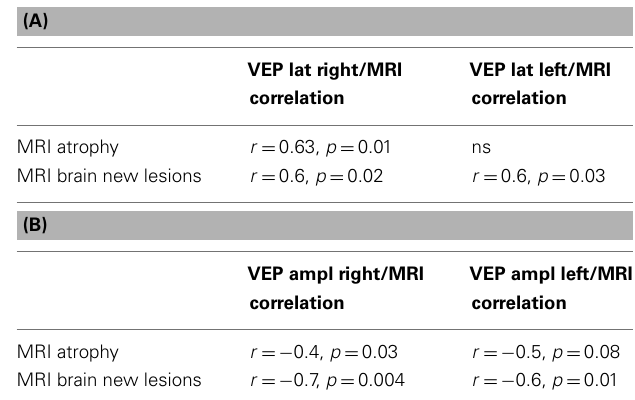
Table 3 | (A) Correlation ofVEP latency and MRI brain atrophy, MRI brain new lesions in all MS patients; (B) correlation ofVEP amplitudes and MRI brain atrophy, MRI brain new lesions in all MS patients .